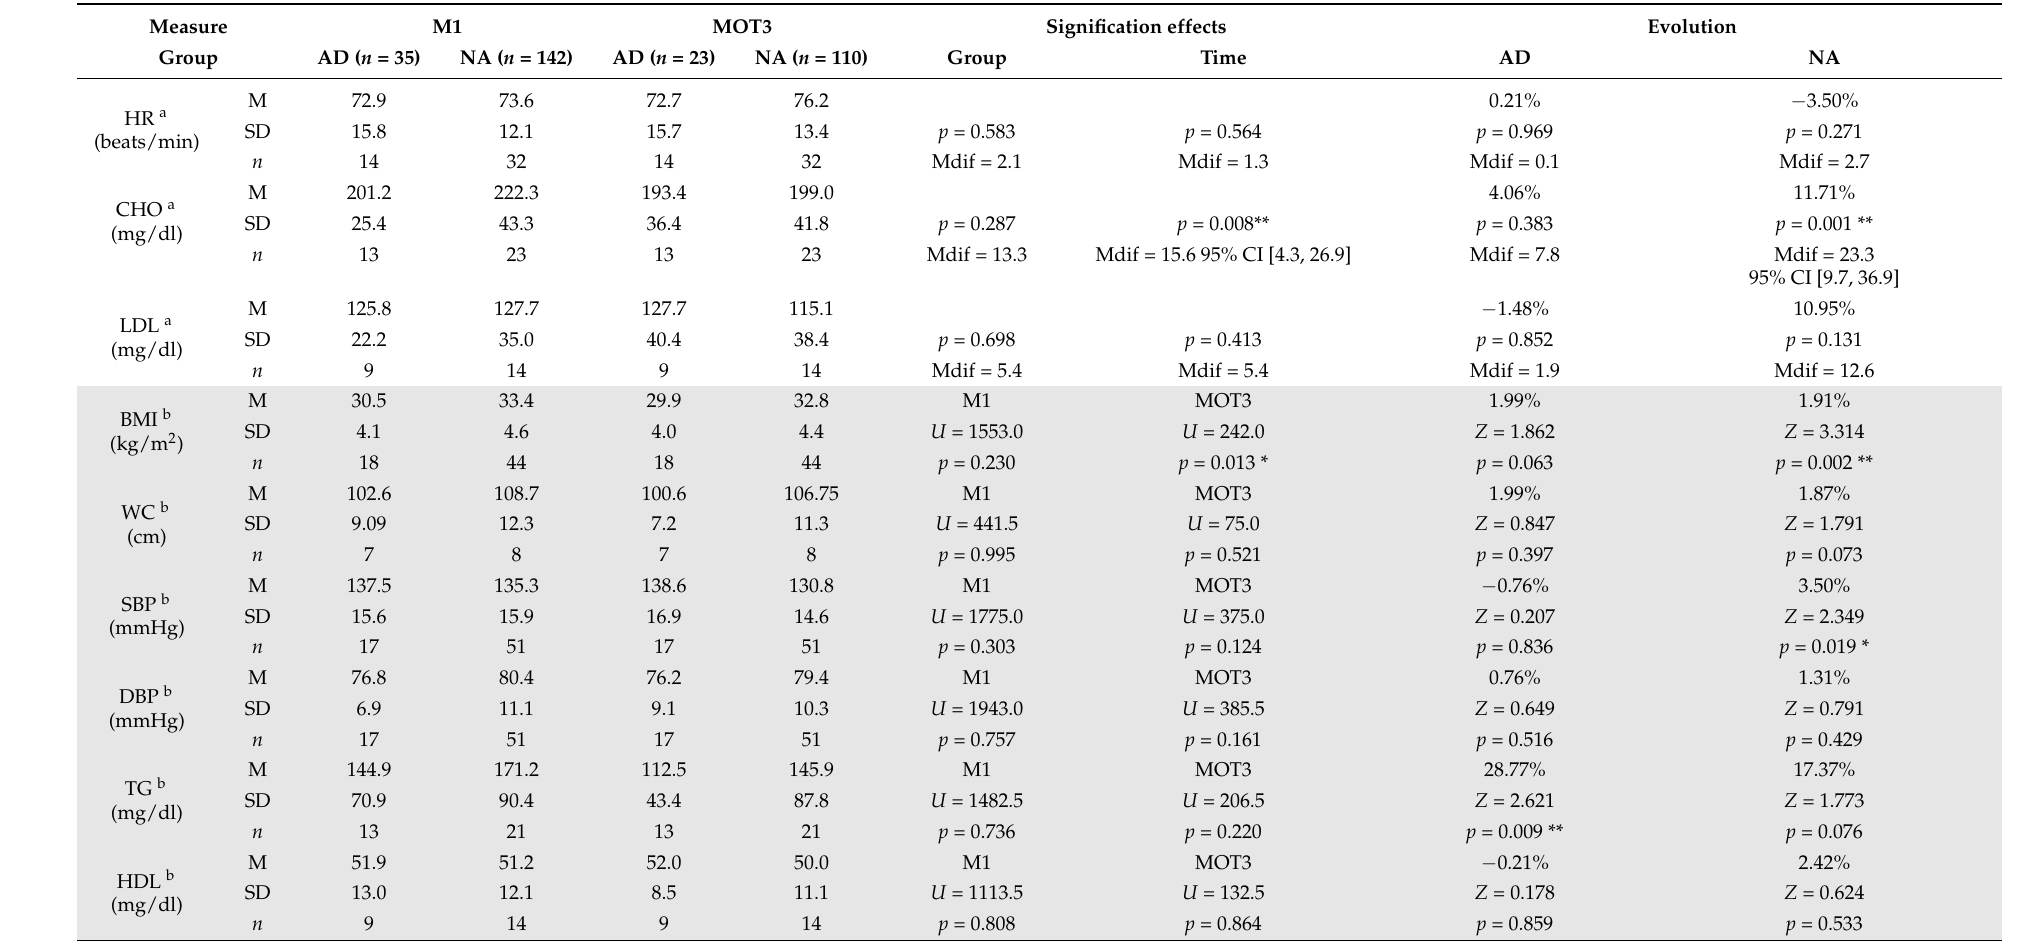
Table 5. Intention-to-treat multivariate analyses of